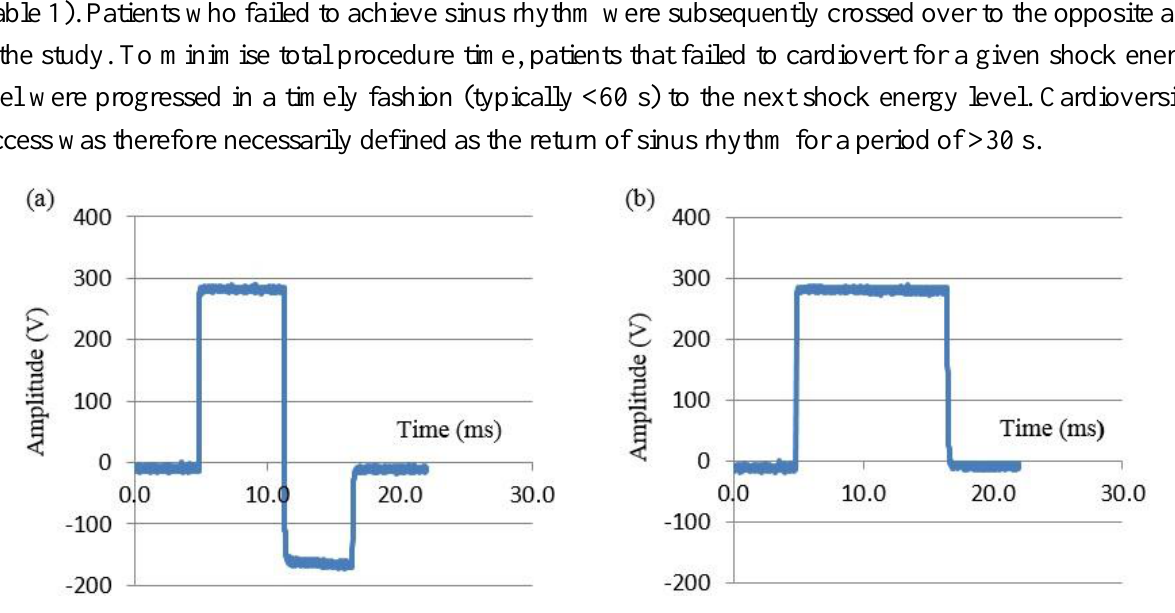
Figure 5. RF defibrillator generated very-low tilt waveforms: ( a ) biphasic (B-VLTR) 12 ms chronosymmetric (6/6 ms) voltage waveform; ( b ) monophasic (M-VLTR) 12 ms